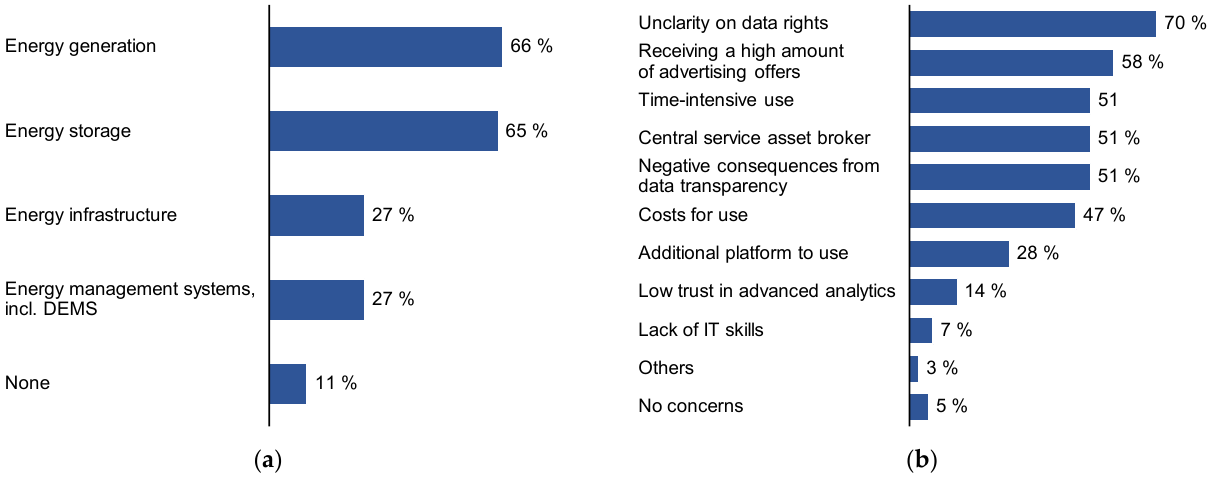
Figure 7. ( a ) The sample’s energy management investment plans until 2025–translated and simplified; ( b ) Concerns of the sample about applying DEMS–translated and simplified.